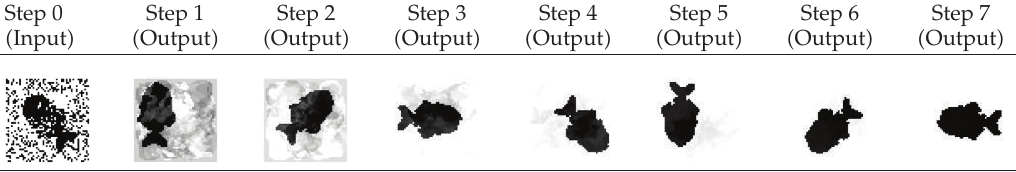
Table 12: Network recall using a noisy input: 700 pixels flipped (cid:3) 28% (cid:4)